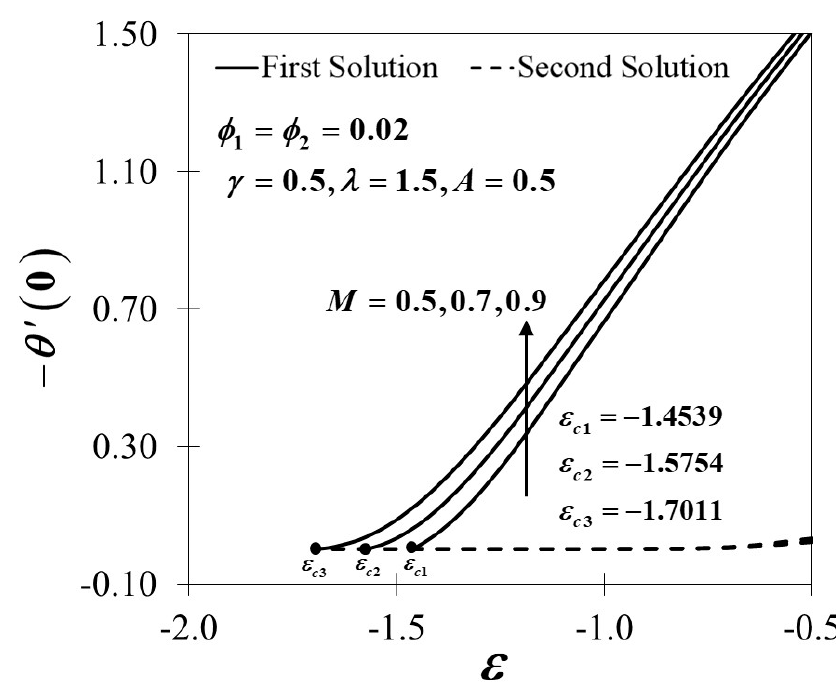
′′ for different values of M .